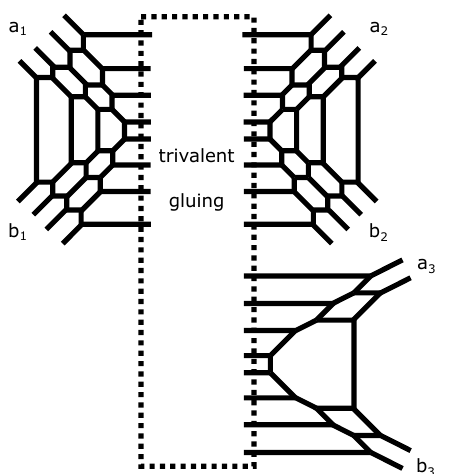
Figure 24. The labeling of [( a 1 , a 2 , a 3 ) , ( b 1 , b 2 , b 3 )] for each (SU(4) 2 × SU(2)) × (SU(4) 2 × SU(2)) in the web diagram in figure 18.